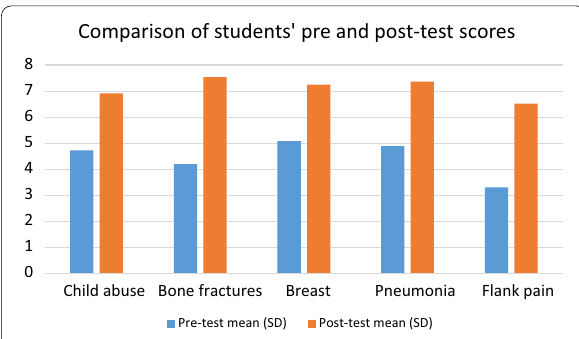
Fig. 1 Comparison of students’ pre- and post-test